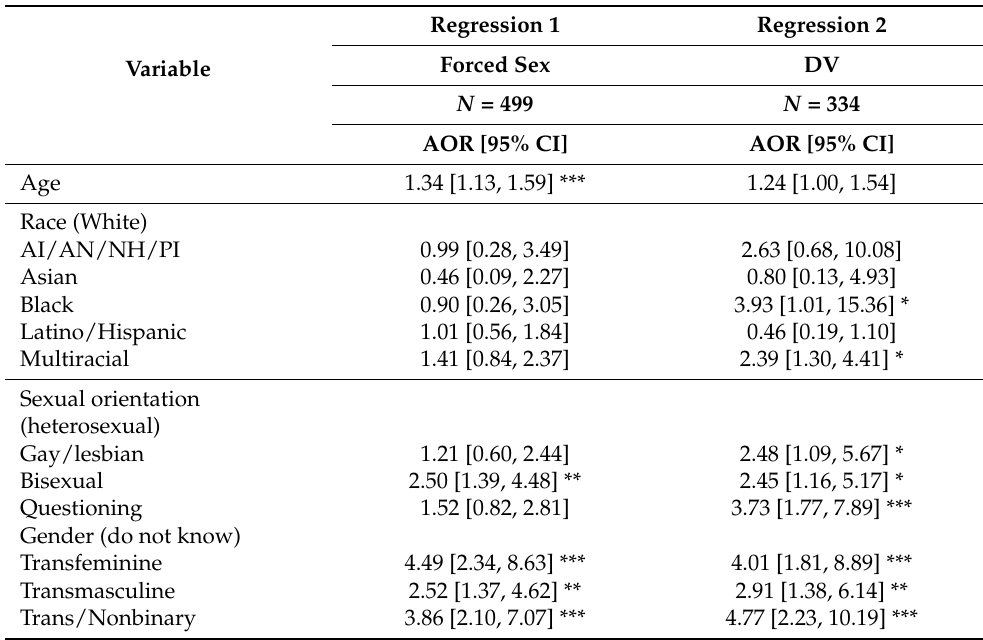
Table 2. Logistic regression models of how age, race, and sexual orientation relate to DV. Regression Variable